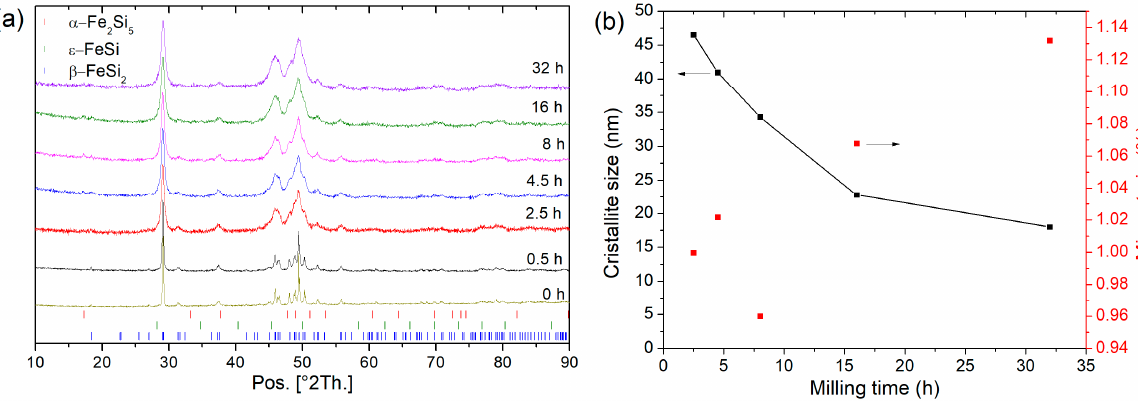
Figure 2. ( a ) Diffraction pattern of β -FeSi 2 samples before and after mechanical milling (0.5 h to 32 h) and ( b ) crystallite size and microstrains. A guideline for the eyes (crystallite size) is shown. Table 1. Influence of the sintering conditions (pressure and temperature) on the relative density and the crystallite size of β -FeSi 2 and β -Fe 0.95 Co 0.05 Si 2 for a dwell time of 5 min.